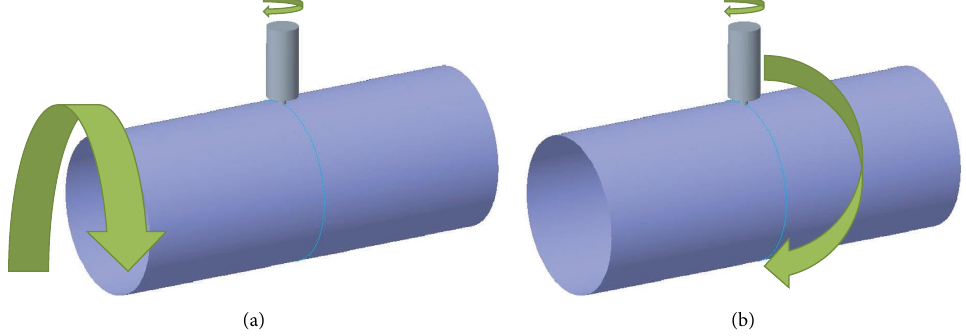
Figure 15: Approaches for FSW of pipes. (a) Pipe rotating approach and (b) tool rotating approach.